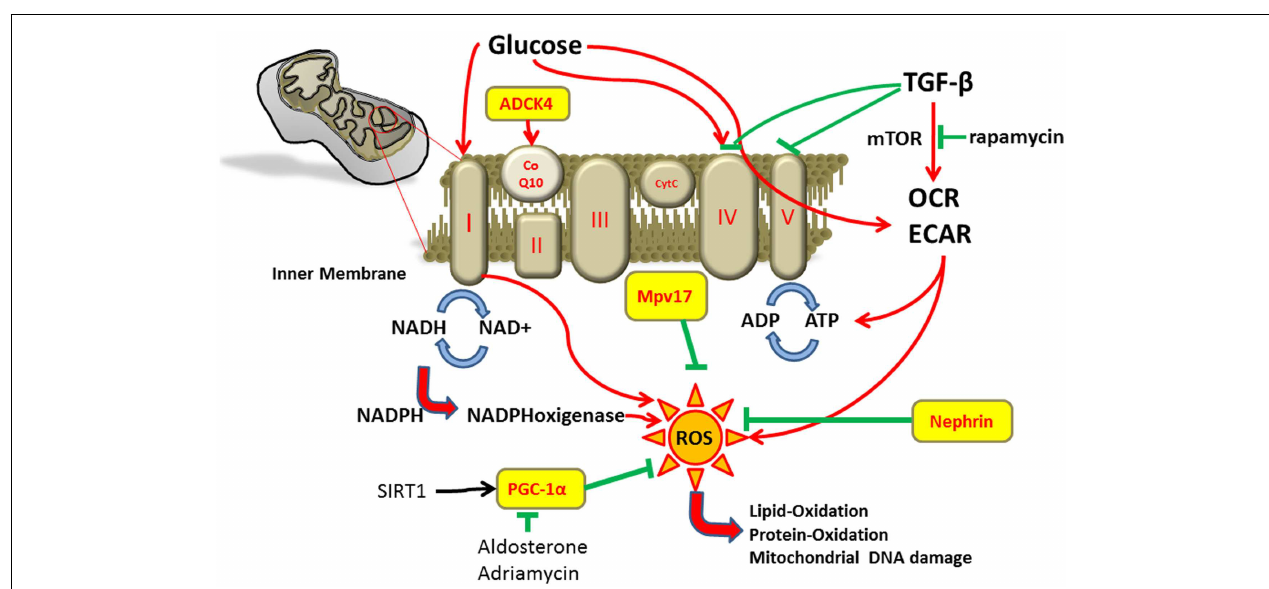
FIGURE 1 | Described pathways affecting energy metabolism and ROS production in podocytes